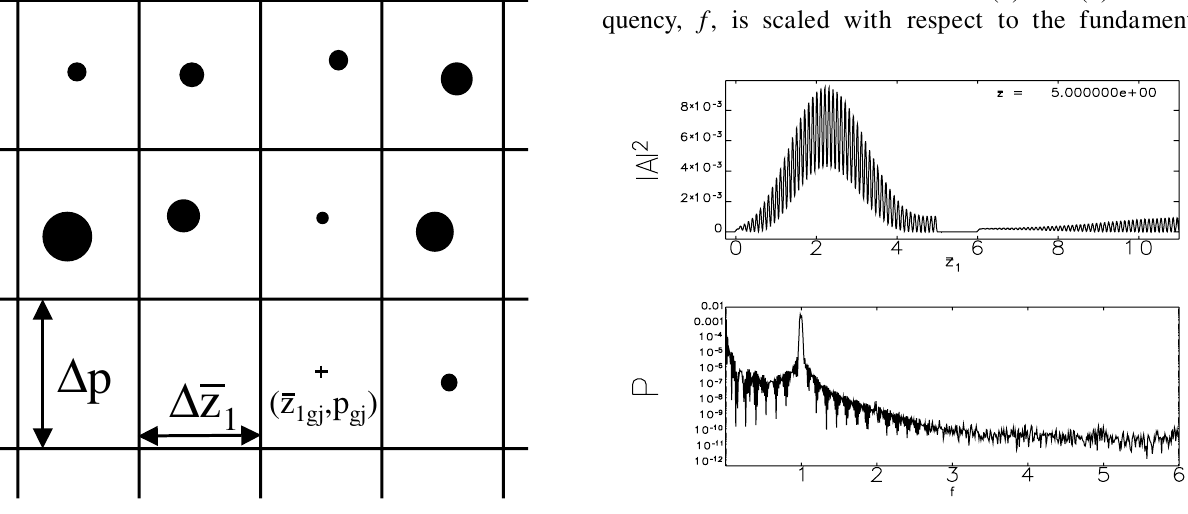
FIG. 4. Top panel: The scaled intensity, j A j 2 , as a function of for a scaled distance through the scaled pulse position (cid:9) zz 1 interaction region of (cid:9) zz (cid:1) 5 and a rectangular profile electron (cid:1) 6 between 0 < (cid:9) zz < 6 . The slippage is demonstrated via pulse duration of (cid:9) ll j e 1 < 5 ; the steady-state region is 5 < (cid:9) zz < 6 ; the region is 0 < (cid:9) zz 1 1 > 6 . Bottom panel: The scaled PSD, P , of vacuum region is (cid:9) zz 1 the radiation as a function of the scaled frequency f